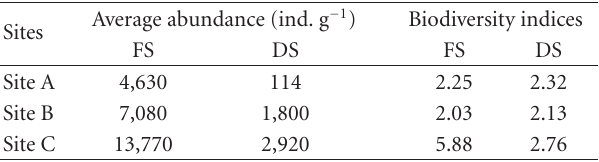
Table 3: Comparison of the ciliate abundance and biodiversity indices in the mangrove forest from Dongzhaigang, Hainan, China.